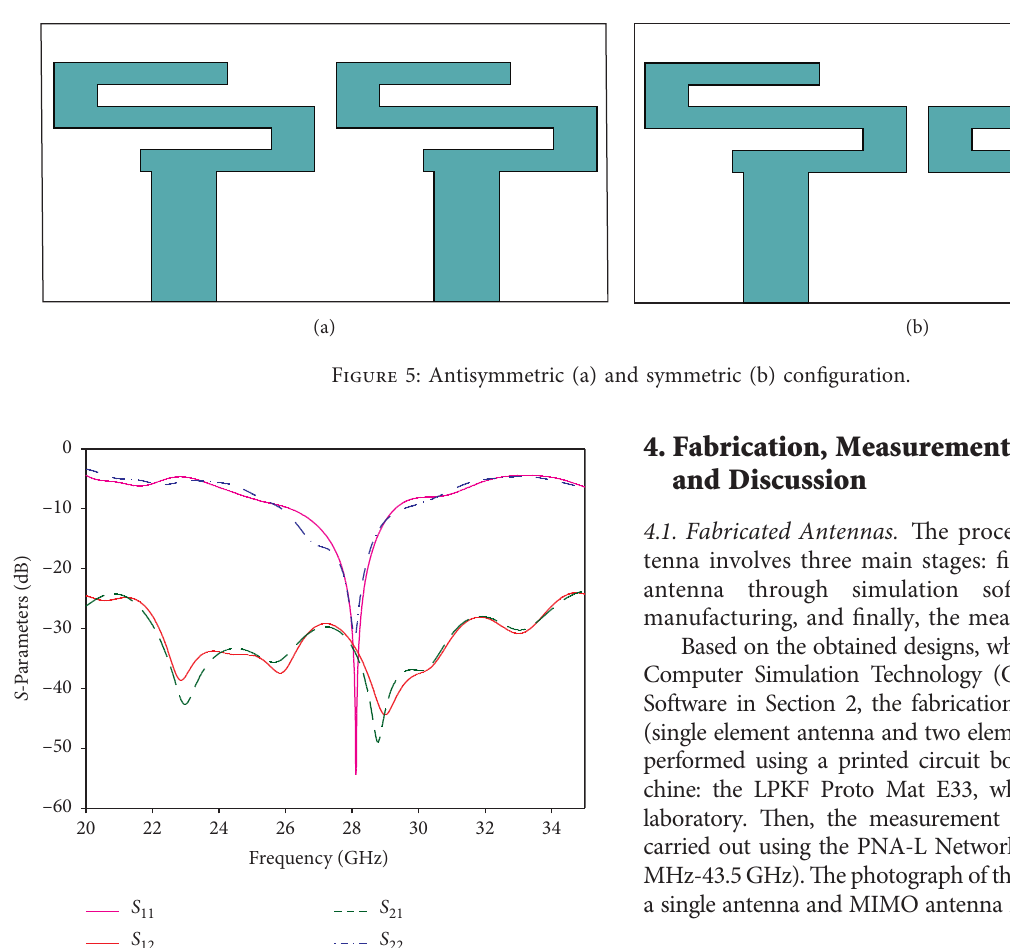
Figure 6: S parameters of asymmetric MIMO antenna.